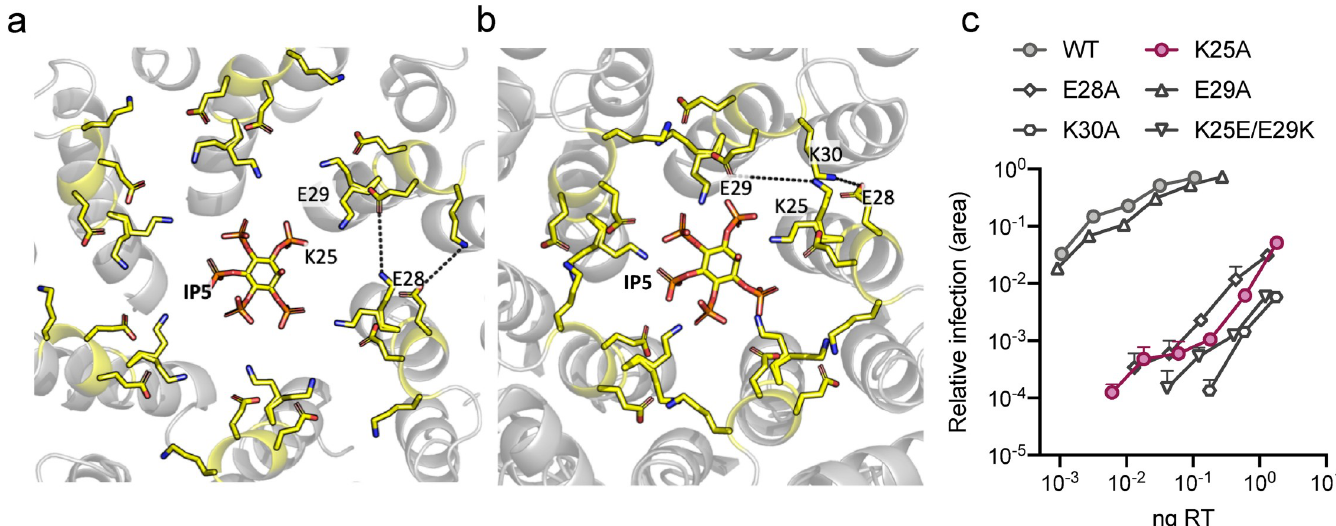
Fig 5. K25 is not required to interact with E29 in hexamers or pentamers. (a) IP5:CA hexamer structure showing the location of K25, E28, E29 and K30. Only the second IP5 molecule in proximity to K25 is depicted. Dotted lines indicate potential interactions. (b) Model of an IP5:CA pentamer, generated using monomers from the hexamer in (a) and the pentamer cryo-EM structure 5MCY[22]. (c) Infectivity of WT HIV and selected mutants. Infectivity is measured using an IncuCyte and determined as the proportion of cell area that is GFP +ve at a given viral dose (in ng RT). Error bars in infection experiments depict mean ± SD of three replicates from one experiment representative of three independent